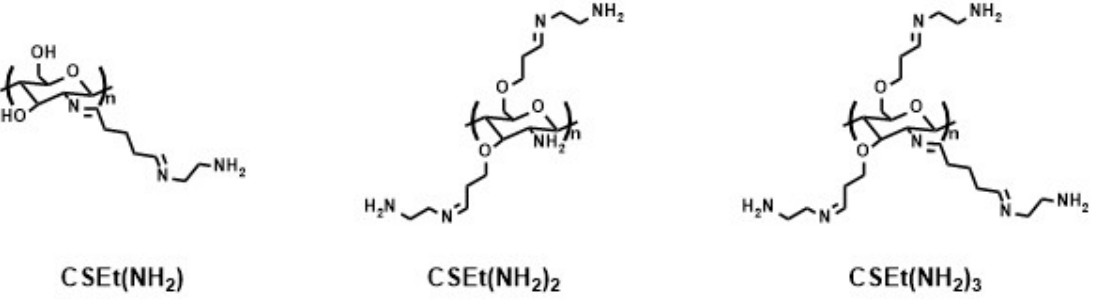
Figure 19. Structure of the aminated chitosan Fe 3 O 4 -CSEt(NH 2 ) 1–3